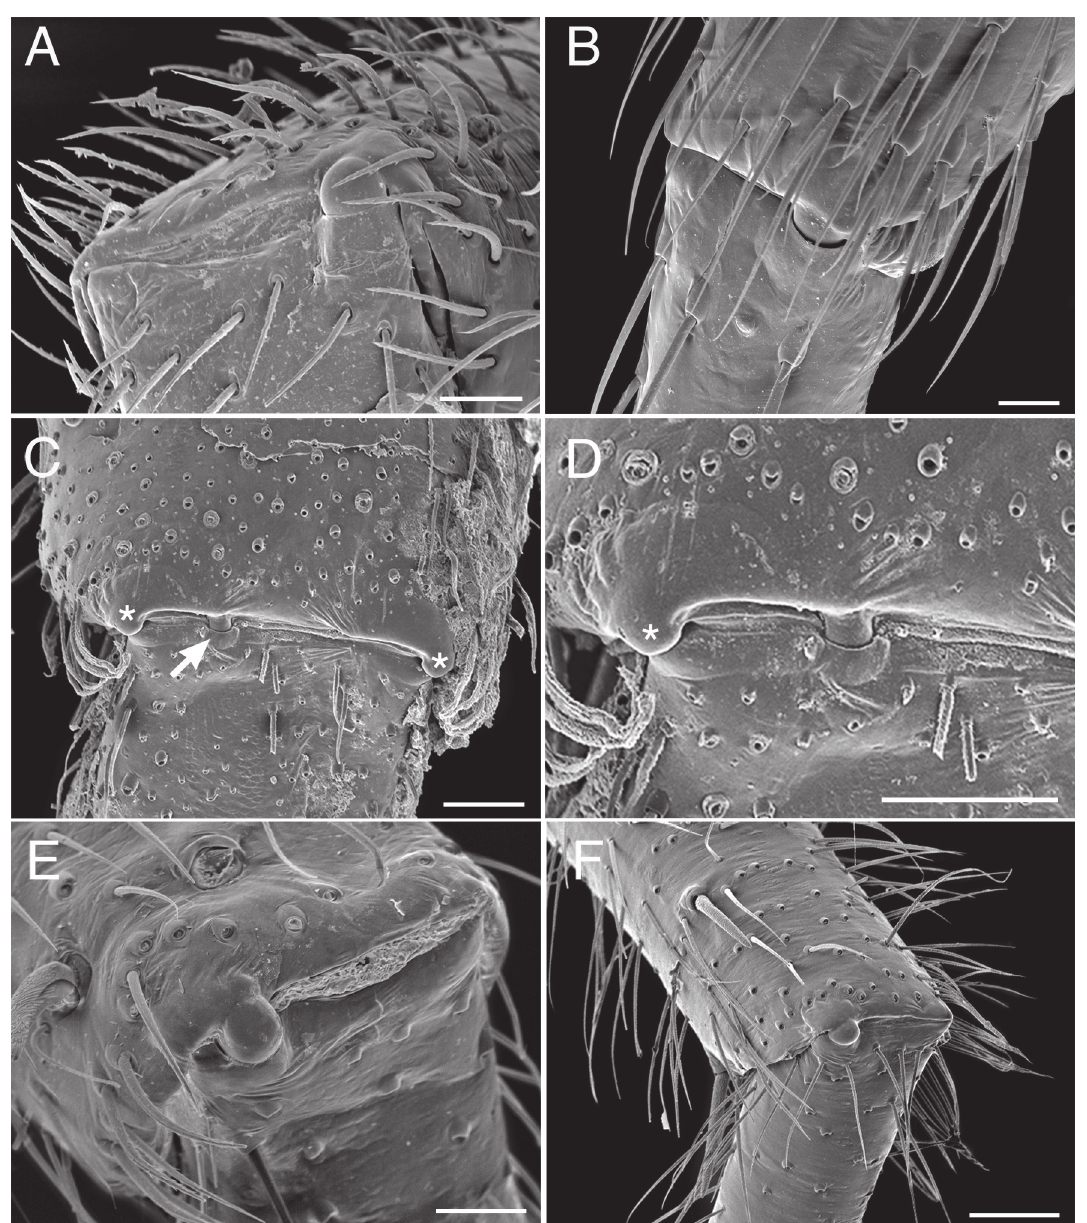
Fig. 18. A . Amphiledorus sp., juvenile, right tibia I. B . Asceua sp., ♂, right tibia and metatarsus IV. C . Cryptothele doreyana Simon, 1890, ♀, left tibia and metatarsus II. D . Idem, detail. E . Cyrioctea marken Platnick & Jocqué, 1992, ♂, left tibia and metatarsus III. F . Holasteron aciculare Baehr, 2004, ♂, left tibia and metatarsus III. Scale bars: A, E = 50 µm, B = 20 µm, C–D, F = 100 mm. Arrow shows tibial process, asterisk indicates